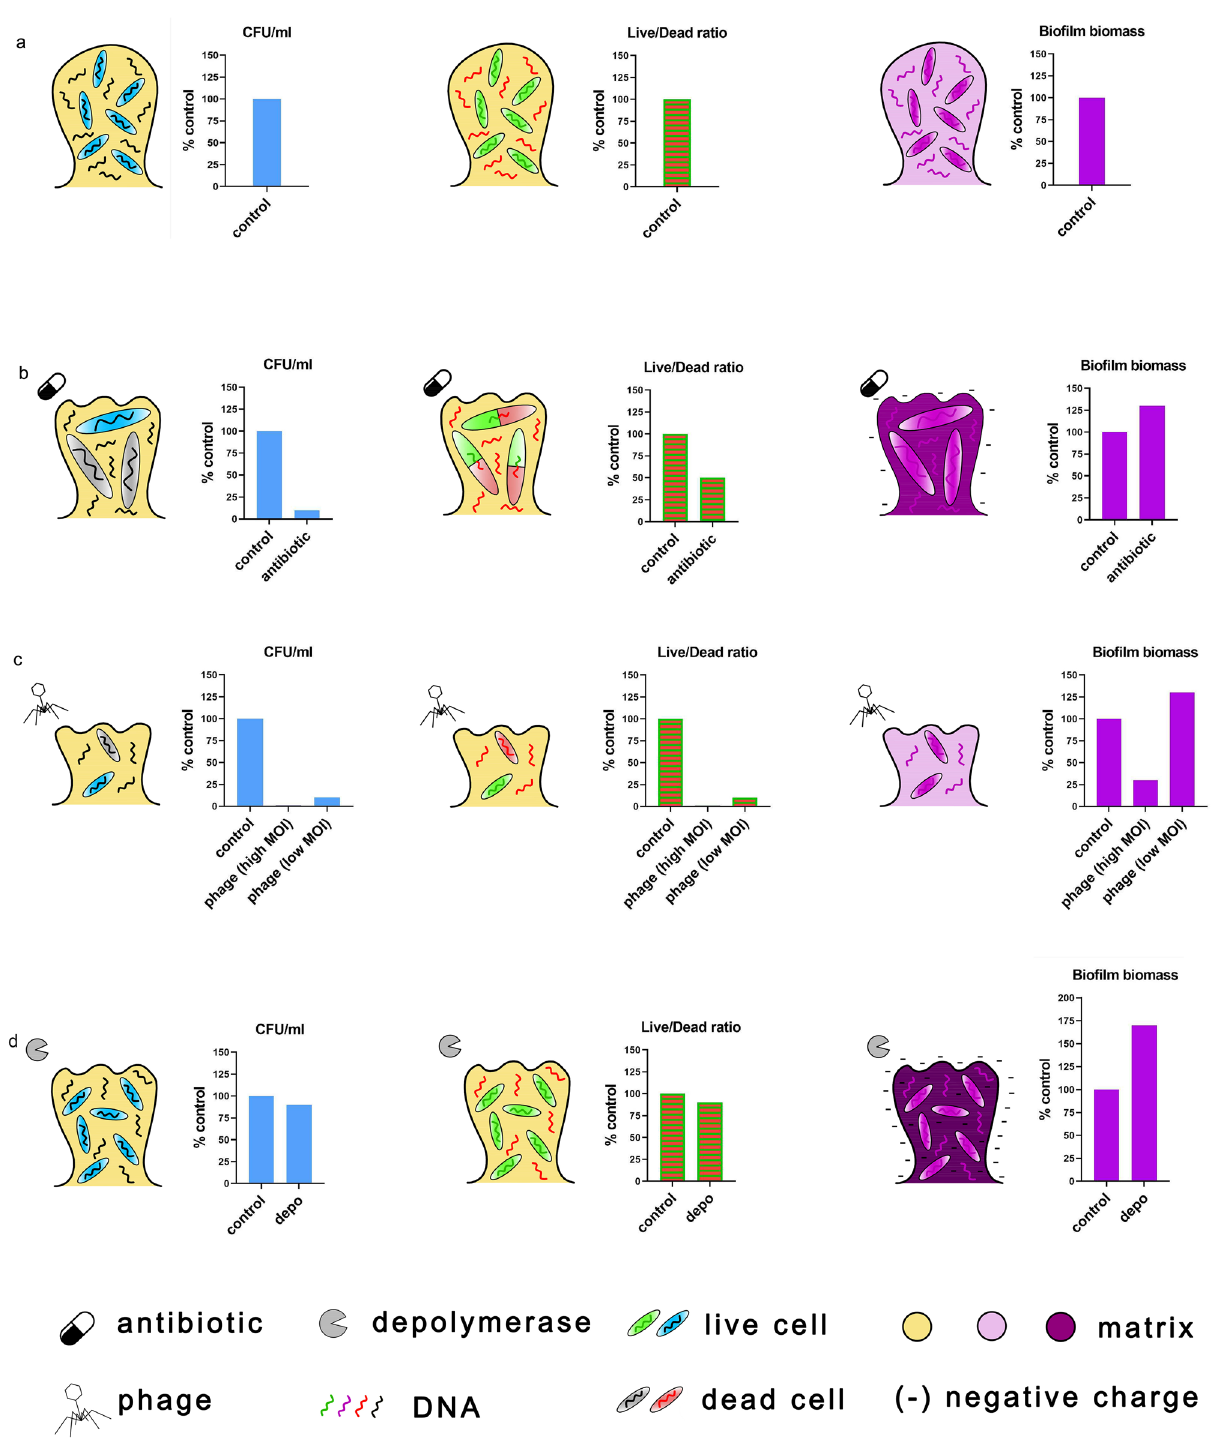
Figure 5. The advantages and limitations of different biofilm monitoring assays used in this study: the colony count (left), LIVE/DEAD BacLight Bacterial Viability Kit (middle), biomass staining with crystal violet (right). The antibiofilm strategies were tested for: ( a ) untreated biofilm; ( b ) antibiotic application; ( c ) phage infection at a high and low MOI; ( d ) depolymerase action. The colony count indicates only culturable bacteria, thus the antibiotic and phage application showed the best antibiofilm effect. The life/dead ratio gave inconsistent results for ciprofloxacin treatment because of the specific antibiotic mode of action causing the elongation of cells and dyes accumulation. The CV staining is based on the dye interactions with the negative charge thus showed a false enlargement of biofilm after antibiotic, depolymerase, and phage at a low MOI